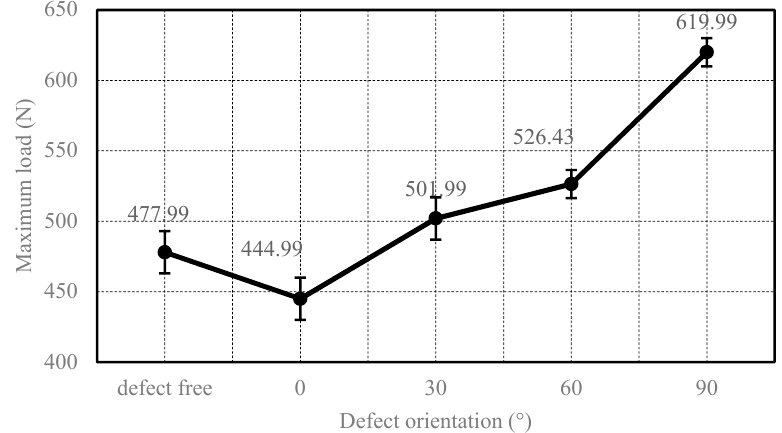
Figure 16. E ff ect of the defect orientation on the maximum load of white samples set. Figure 16. Effect of the defect orientation on the maximum load of white samples set.